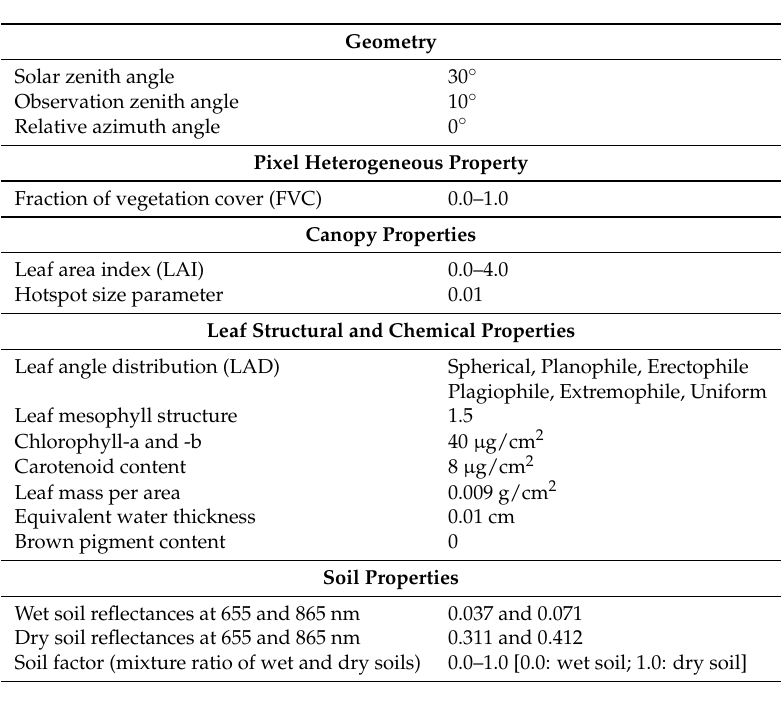
Table 1. Input parameters used in the numerical